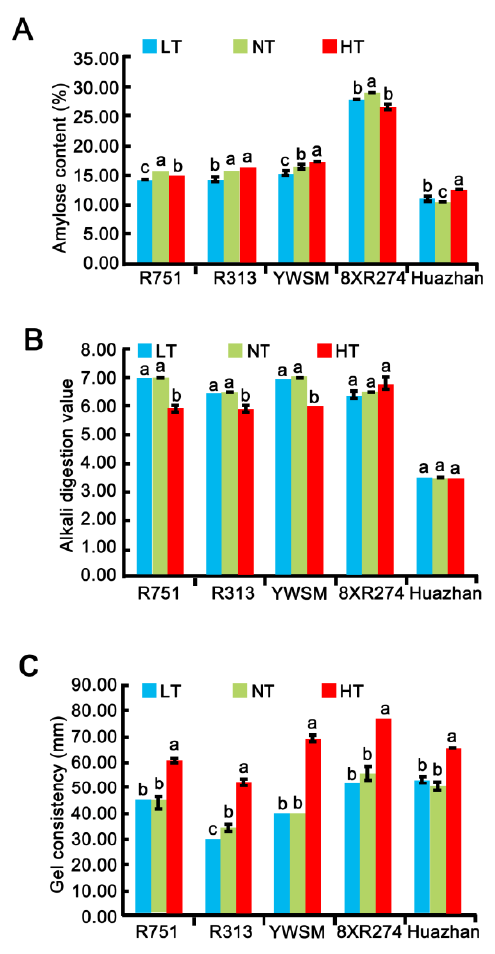
Figure 4. Apparent amylase content ( A ), alkali digestion value ( B ), and gel consistency ( C ) of five restorer lines under LT (low temperature), NT (normal temperature), and HT (high temperature). Data are shown as mean ± standard error of triplicate measurements. Different letters are added above standard deviation to express significant difference ( p < 0.05).